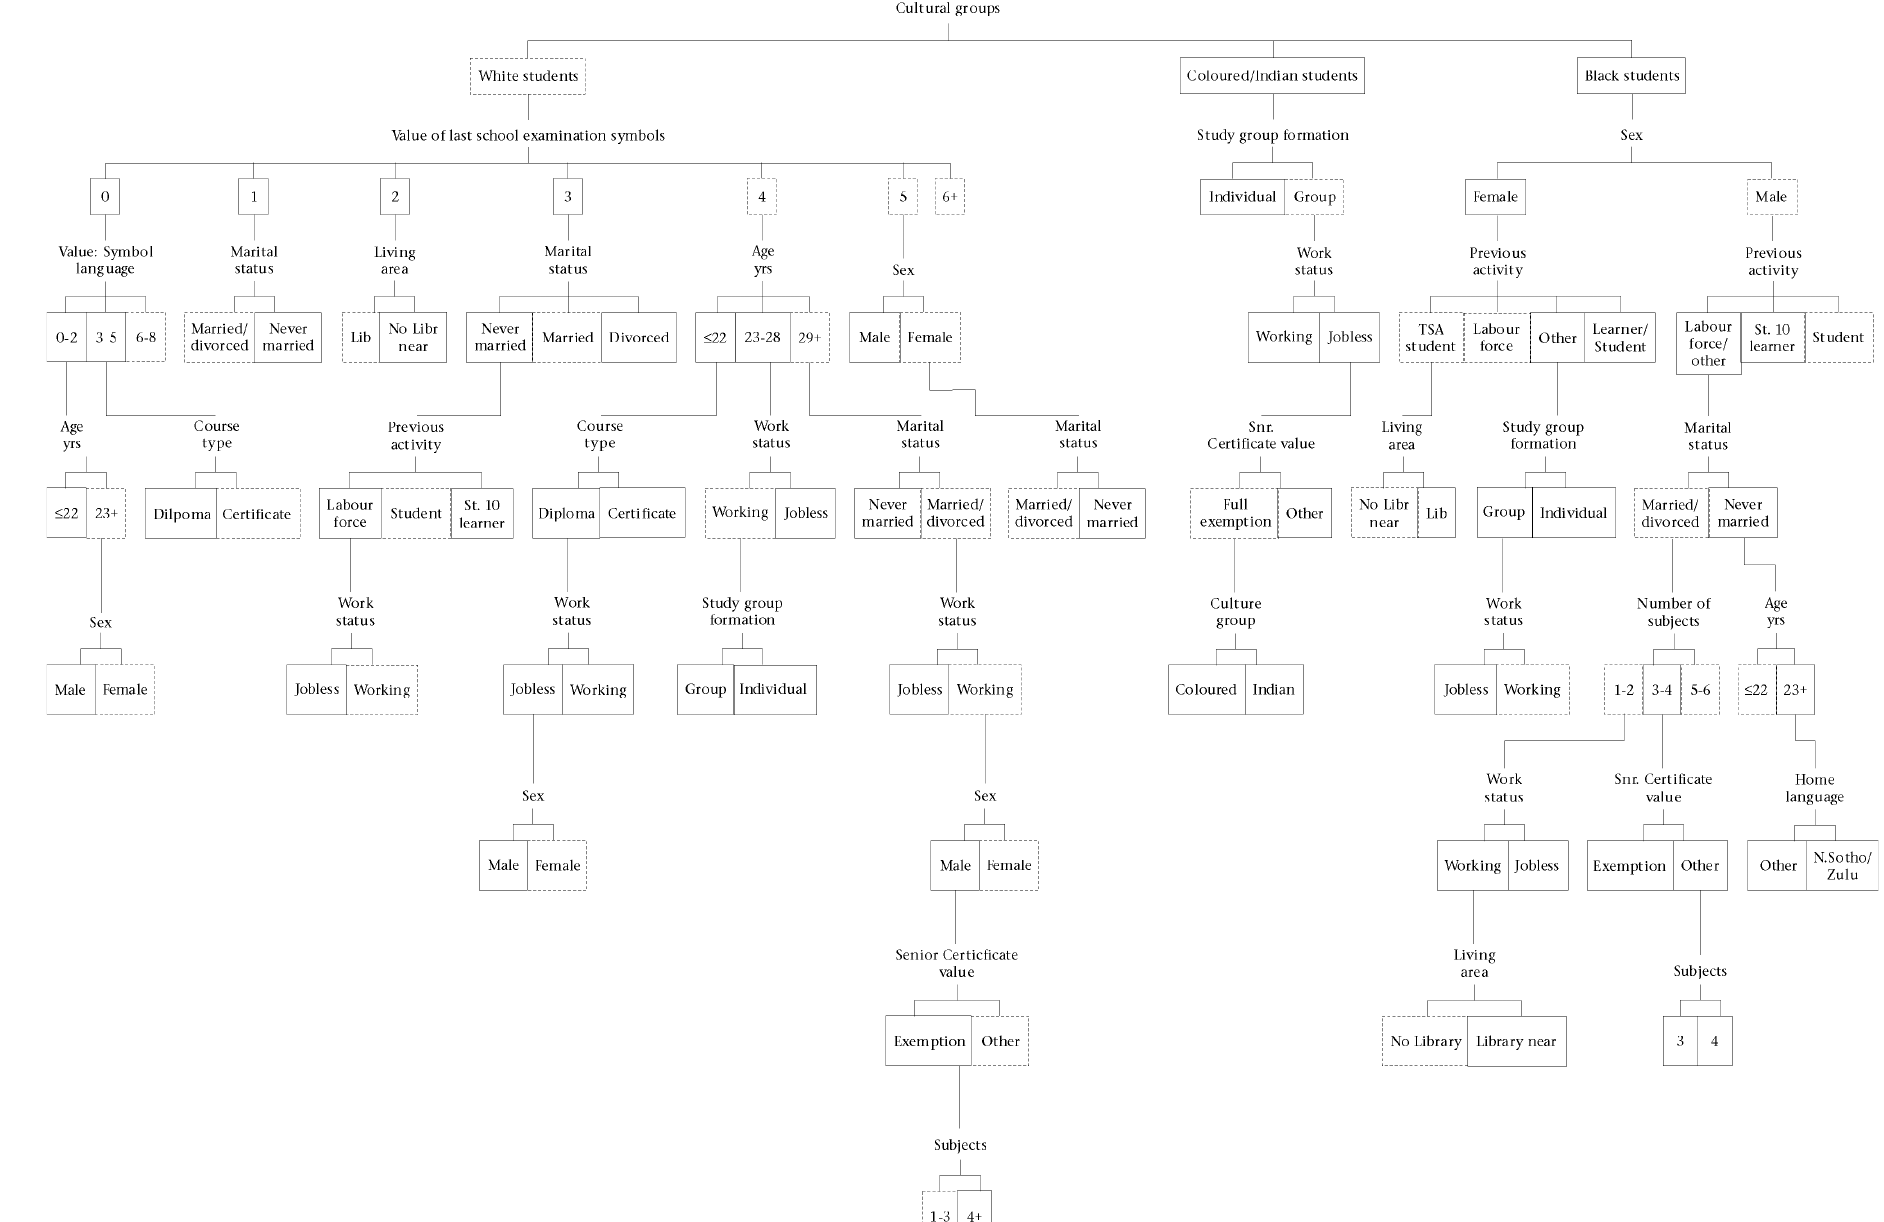
Figure 2: Results of the CHAID-analysis for the data from 13 590 TSA students. (Dotted frames show better academic